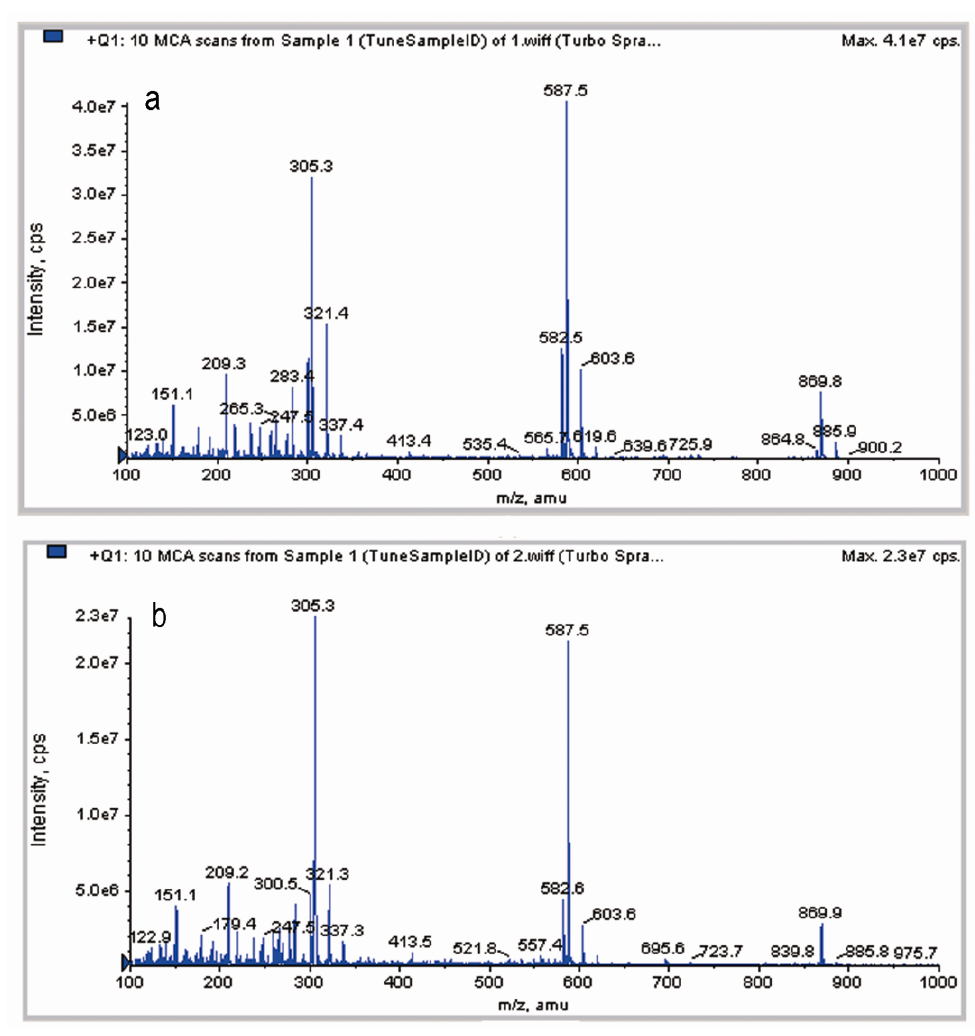
Figure 5. LC-MS analysis of artemisinin before and after RESS processing. ( a ) unprocessed artemisinin; ( b ) processed